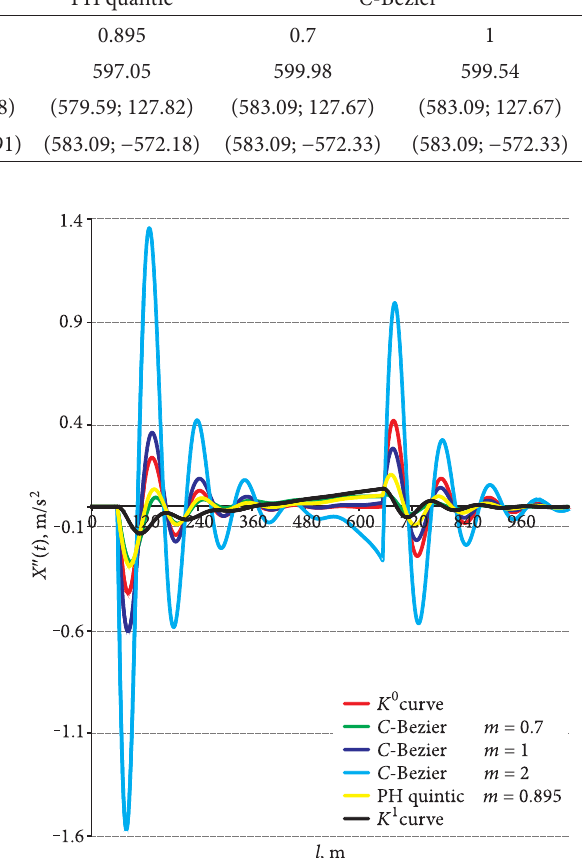
Fig. 12. Acceleration of oscillating motion X ″ as a function of curve length